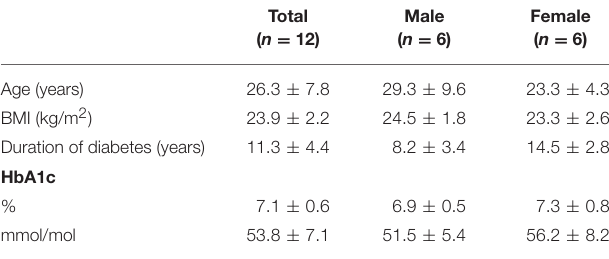
TABLE 1 | Baseline characteristics in people with